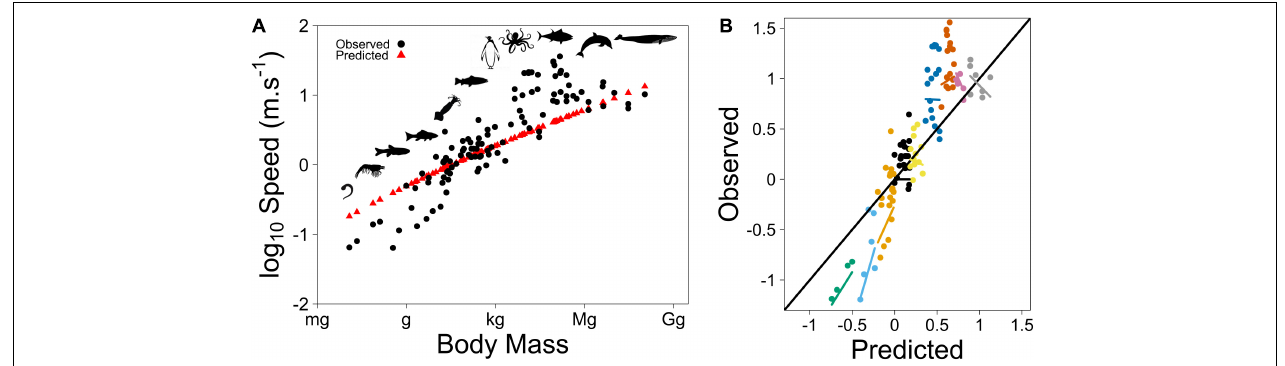
FIGURE 1 | (A) Species-specific speed according to body size for organisms moving in aquatic systems. Speed increases with body size, since overall muscular power generating thrust increases with size. Despite variation among species, the predicted speed fits data well [data from Hirt et al. (2017)]. (B) Observed versus predicted data. Black line has a slope of 1 and intercept of 0. Color points represent the different size ranges. Colored lines are (non-significant) regression lines of the corresponding